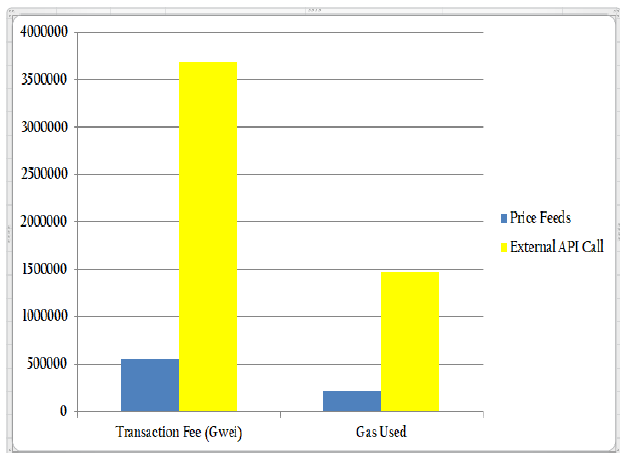
Fig. 6. Comparison of price feeds and external API contract